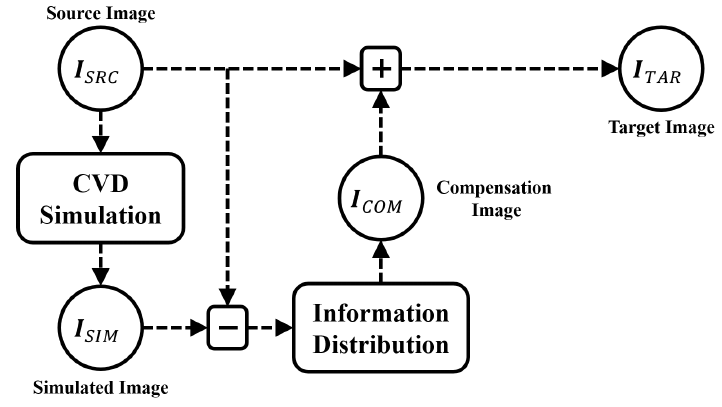
Figure 1. Daltonization